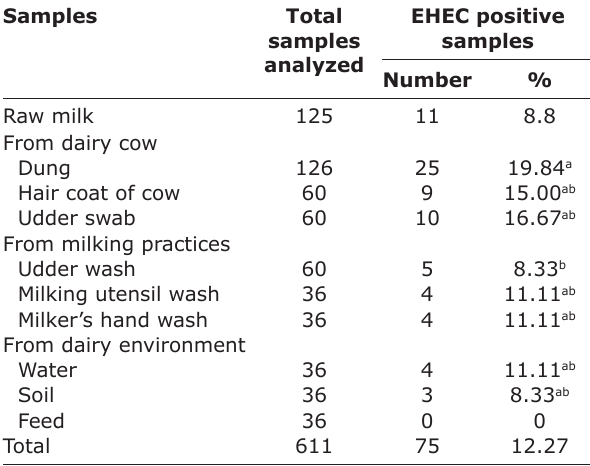
Table-2: Overall, the occurrence of EHEC in raw milk and various samples from dairy cattle rearing environment. Samples